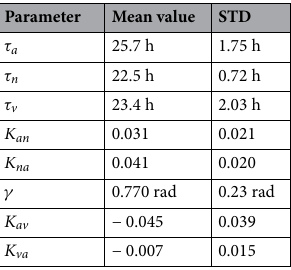
Table 1. Intrinsic oscillator periods estimated from experimental data and fitted model parameters of (1) for the fully syncrhonised AP-NTS-4Vep oscillations, and their standard deviations (STD).